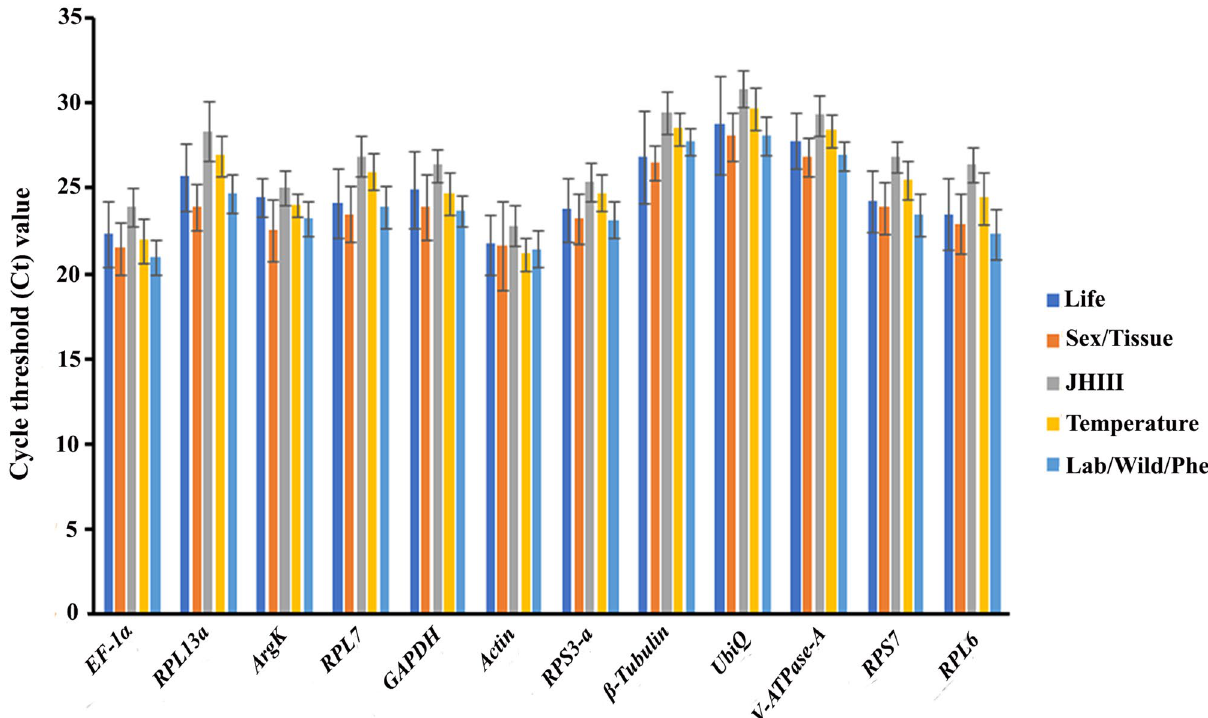
Figure 2. Expression range of Ct (Cycle threshold) values of candidate reference genes under different experimental conditions in I. typographus . The different conditions included in biotic conditions: developmental stages (i.e., larvae, pupae, and adult stages), sex-specific (male and female), tissue types (head, midgut, fat body) and abiotic conditions: different treatments (such as temperature; Juvenile hormone III; wild-collected vs long- term laboratory-reared Table 2) in life stages and various tissue types of the beetle according to the 2 − ΔΔCT method for gene normali- zation using most and least stable reference genes 51 . Target genes mRNA expression level was analysed using one-way ANOVA using GraphPad Prism software. P -value < 0.05 was deployed as the cut-off to indicate signifi- cant differences between tested samples. Results Candidate reference gene selection and PCR efficiency.